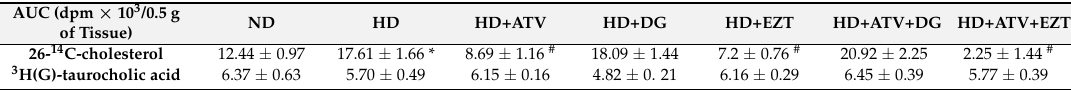
Table 4. Effect of atorvastatin, ezetimibe, diosgenin or their combinations on fecal 26- 14 C-cholesterol or 3 H(G)-taurocholate elimination in hypercholesterolemic rats. AUC (dpm × 10 3 /0.5 g of